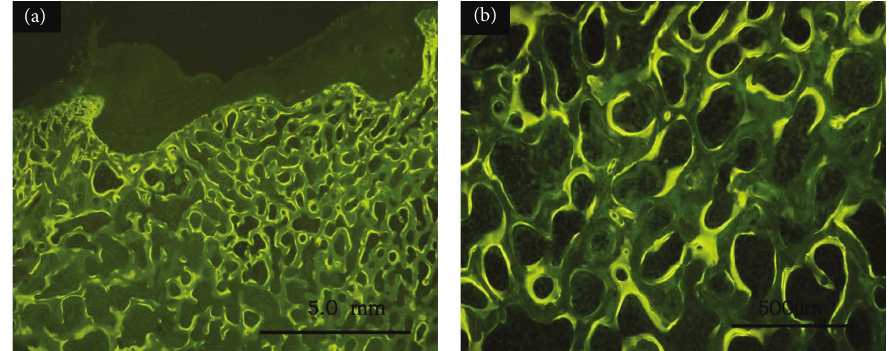
Figure 8: Tetracycline fluorescence labeling of new bone under fluorescence microscopy at 6 months: (a) ( × 12.5), (b) ( ×